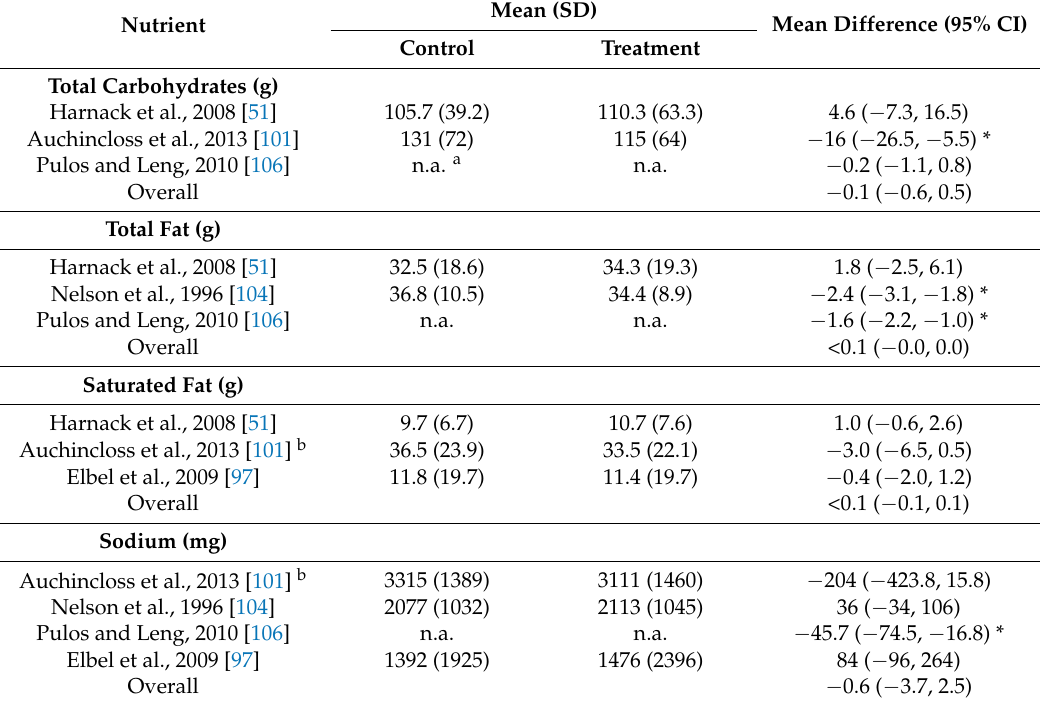
Table 3. Impact of menu labeling on carbohydrates, fat, saturated fat, and sodium ordered or consumed.